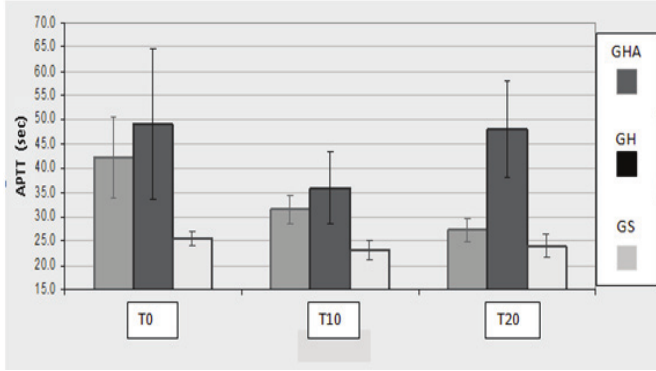
FIGURE 3 - Distribution (means and standard deviations) of activated partial thromboplastin time (APTT) at T0 (t=0 min), T10 (t=10 min) and T20 (t=20 min) in the GHA (heparin plus adhesive), GH (heparin only) and GS (without heparin or adhesive) groups.